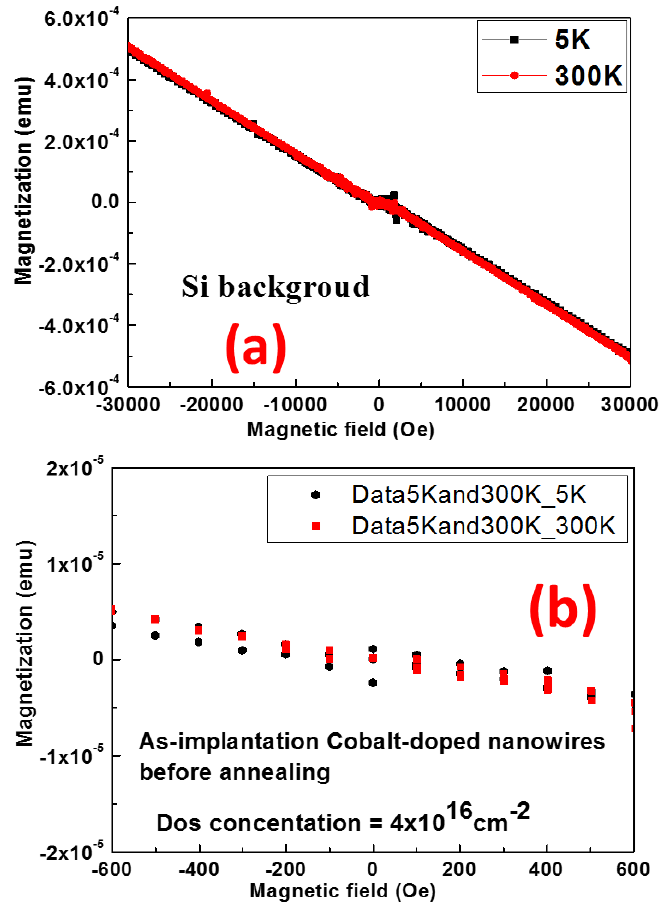
Figure 5. ( a ) M–H measurement from Si background at 5 K and 300 K, ( b ) M–T measurement with applied field of 0–100 Oe from a cobalt-doped GaN Nanowire before annealing with dose concen- tration of 4 × 10 16 cm − 2